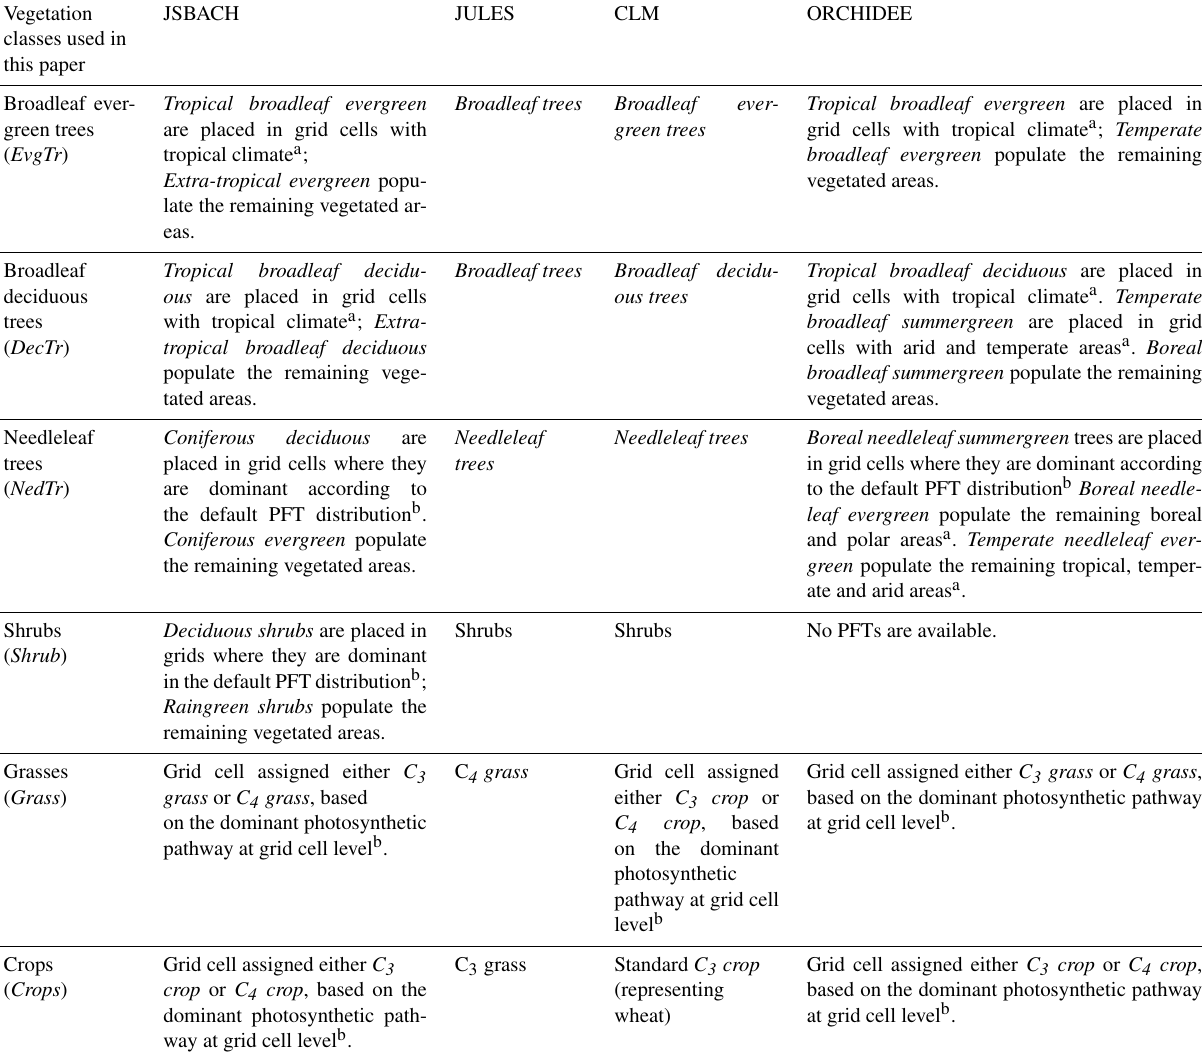
Table 1. Summary of how the specific plant functional types (PFTs) of the different land surface models (LSMs) are mapped into the six broad vegetation classes used in this study. Model-specific nomenclature of PFT is used in